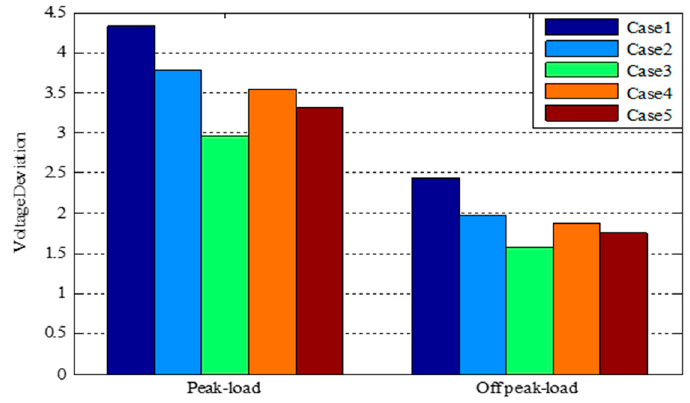
Figure 1. The expected voltage deviation for different cases.